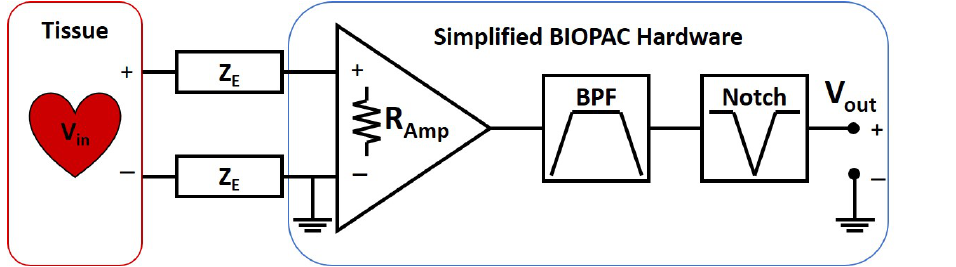
Figure 6. Simplified schematic diagram of the ECG